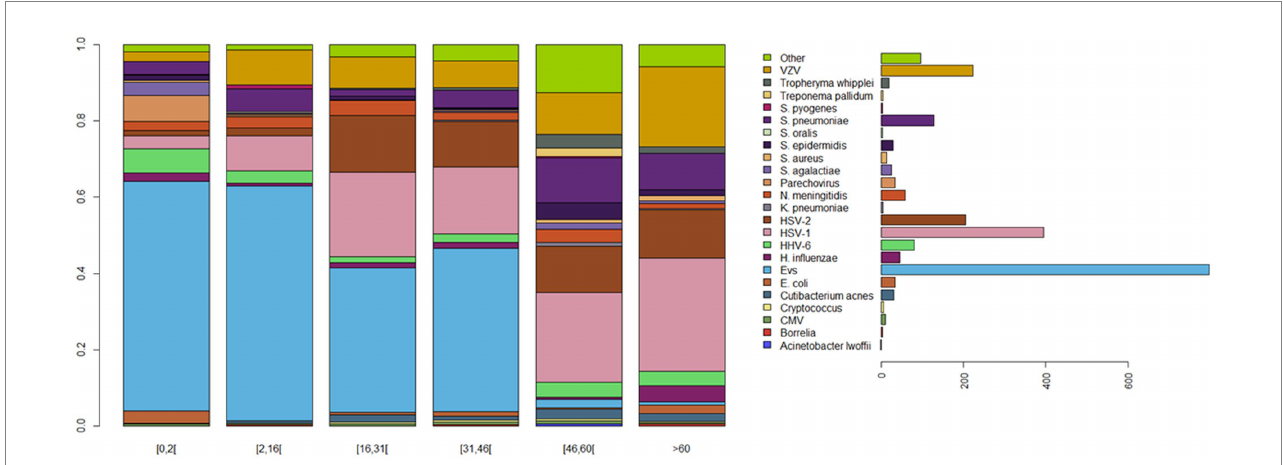
FIGURE 2 Comparison of the microbial diversity of community-acquired meningitis. Patient age-dependent pathogen diversity: patients aged 0–2 and 2–16 were mostly diagnosed as positive for Enterovirus, the majority of patients aged 16–46 years old were positive for Enterovirus, HSV-1 and HSV-2, patients >46 years were positive for HSV-1, HSV-2, VZV, and bacterial infections. The legend shows the total abundance of each pathogen. Pathogens with global abundance less than 1% are gathered in group “Other.” Evs, Enterovirus; HSV-1, Herpes Simplex Virus 1; HSV-2, Herpes Simplex Virus 2; VZV, Varicella Zoster Virus; and HHV-6, Human Herpes Virus